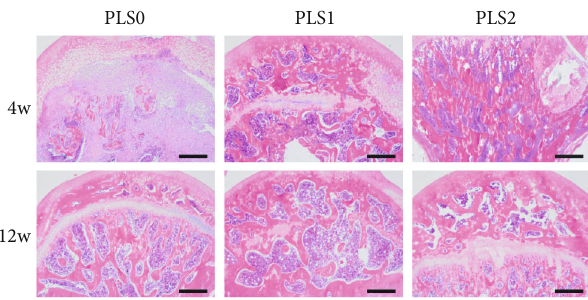
Figure 5: ALP staining of the histopathological osteogenic marker (200x).